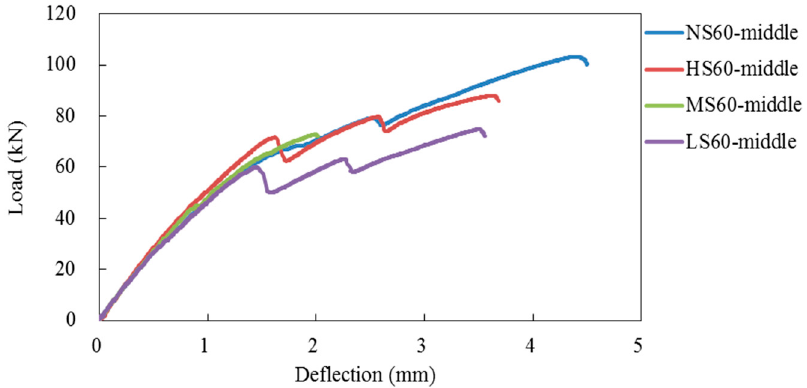
Figure 19. Load-deflection relationship for the small RC beams. Table 4. Comparison of the experimental load of the reinforced concrete (RC) beam shear testing.